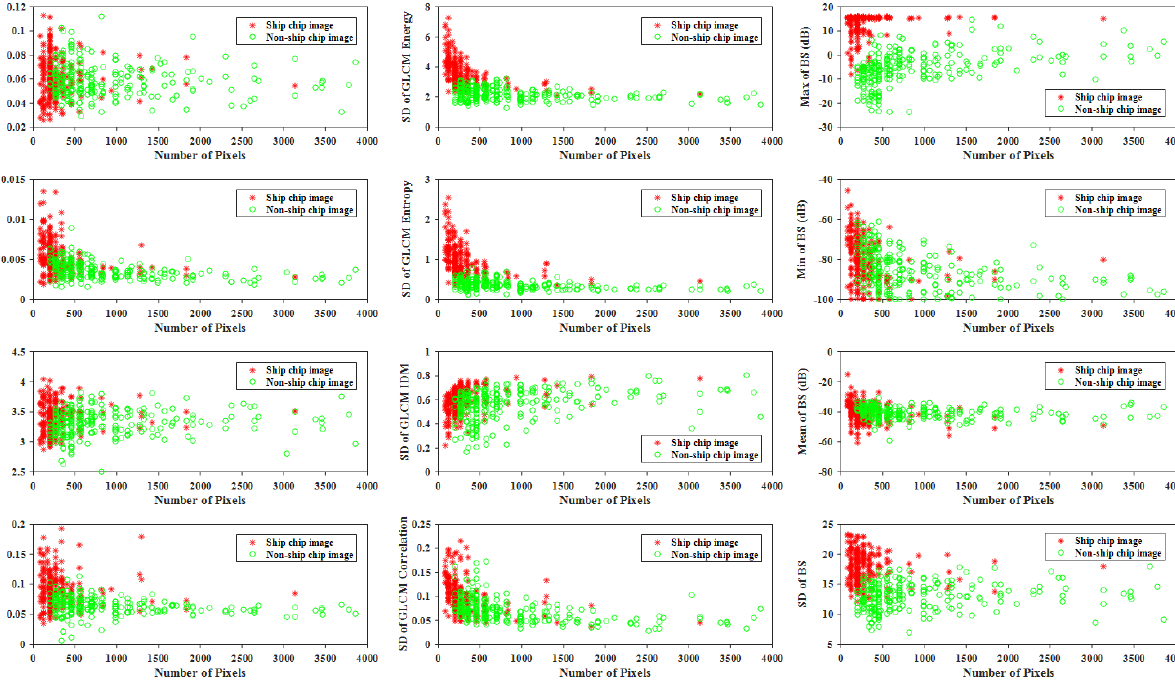
Fig.5 Features analysis for ship and non-ship slice